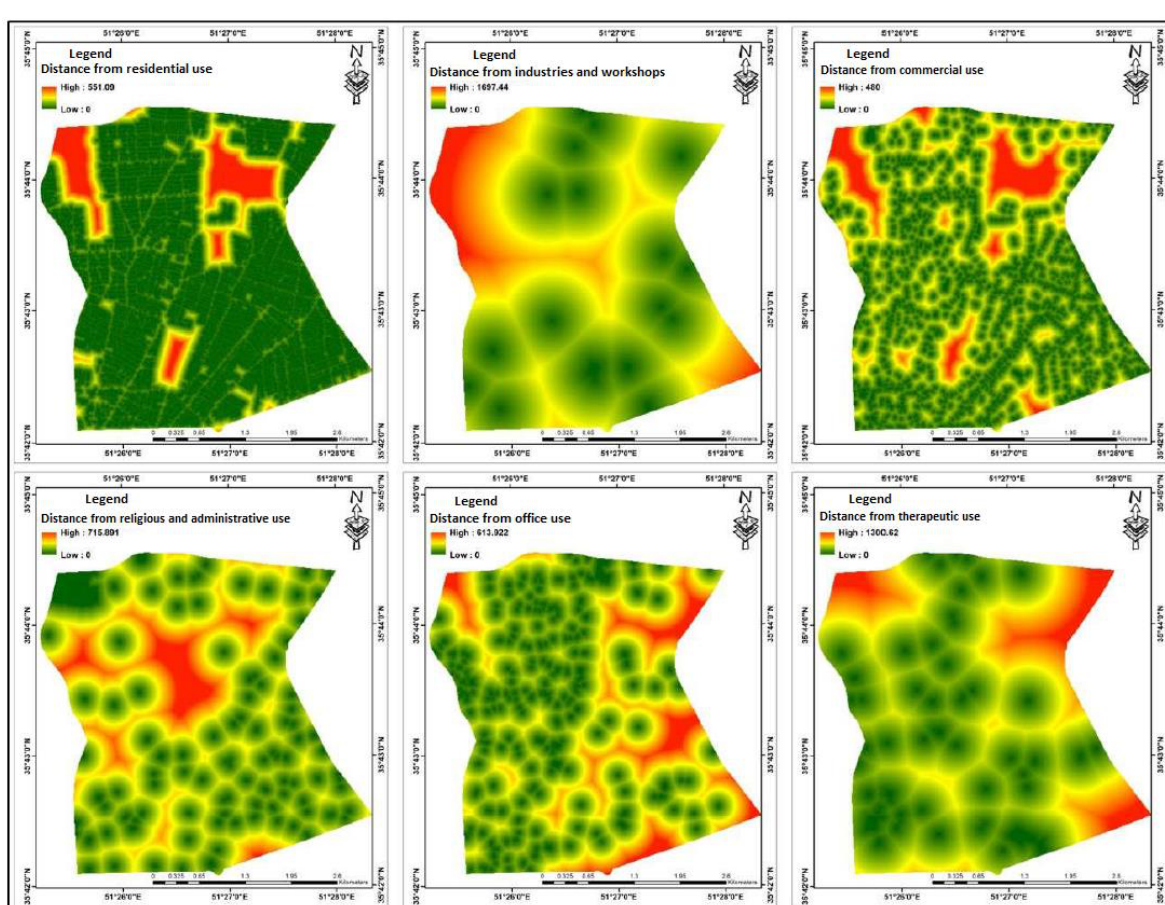
Figure 4. Distance from incompatible